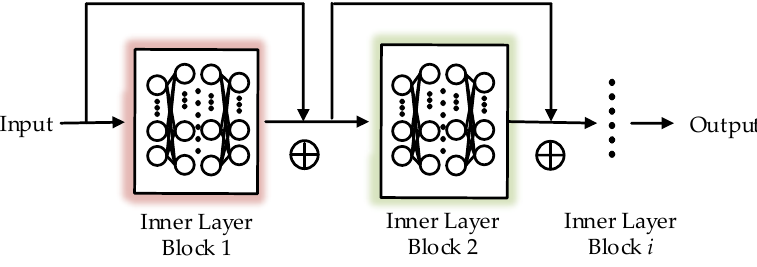
Figure 4. The structure of residually connected deep neural networks.